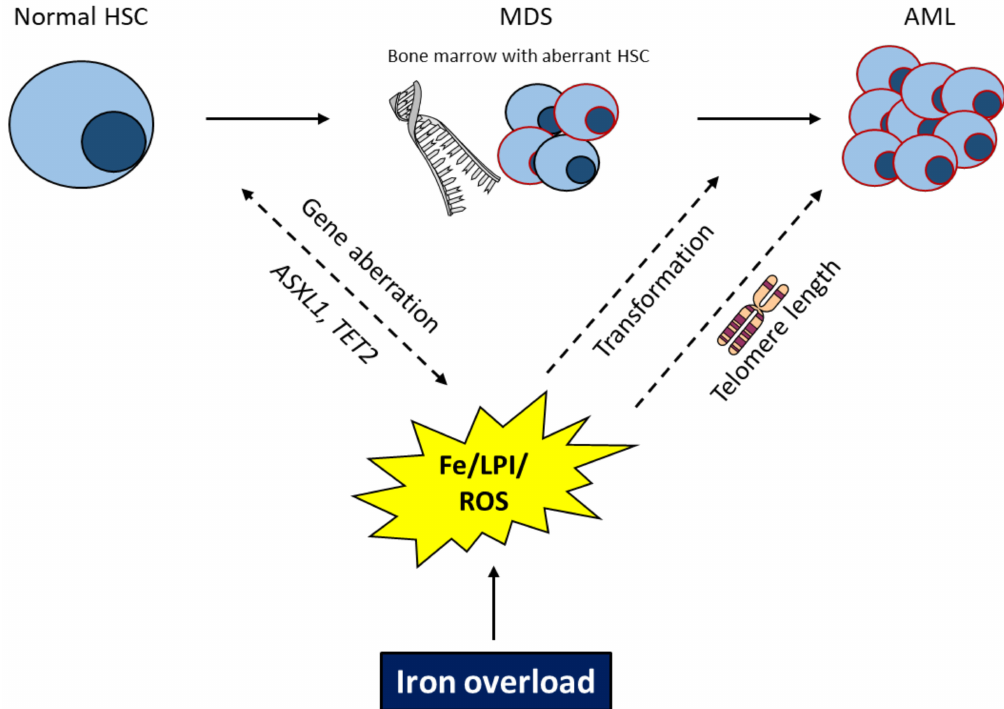
Figure 2. Possible roles for iron overload in MDS disease evolution. Dashed lines indicate a yet unclear interrelation. Myelodysplastic syndrome (MDS); hematopoietic stem cell (HSC); iron (Fe); reactive oxygen species (ROS); AML acute myeloid leukemia